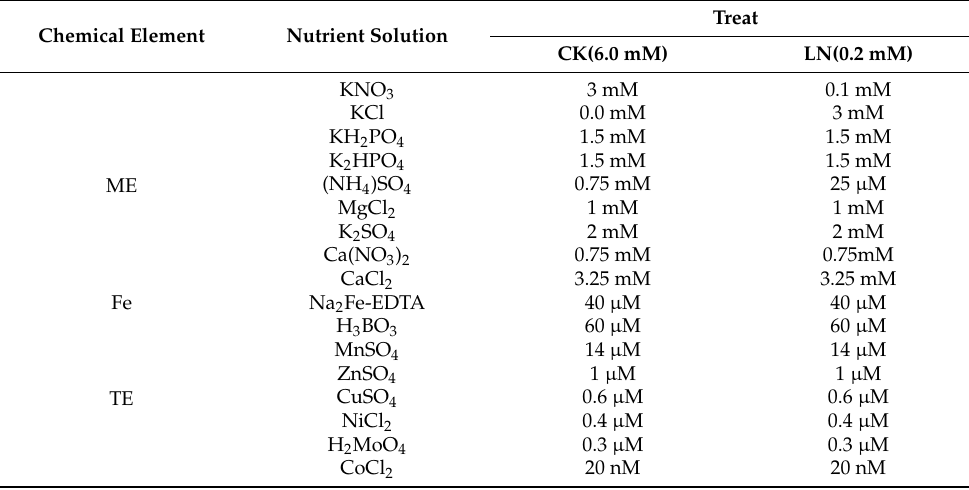
Table 5. The hydroponic nutrient solution content for each